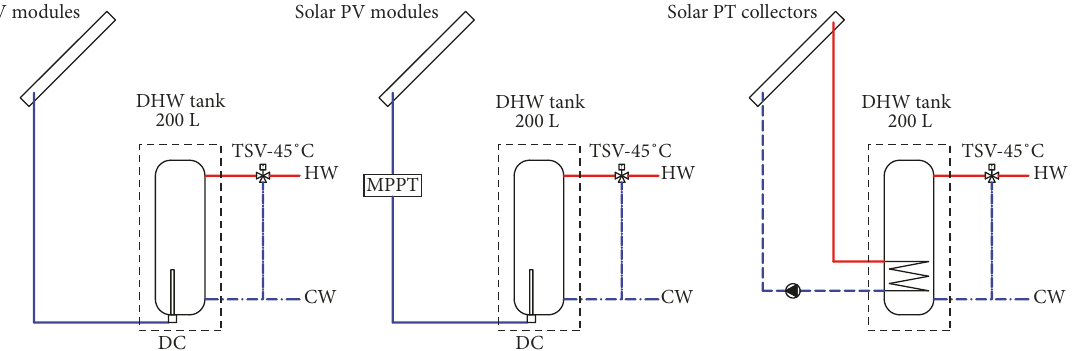
Figure 5: Scheme of solar hot water systems (PV without MPPT, PV with MPPT, and solar